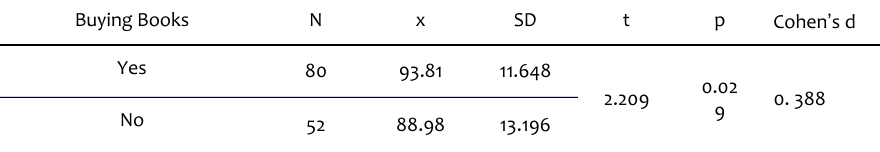
Table 6. Students' reading motivation scores in relation to buying books